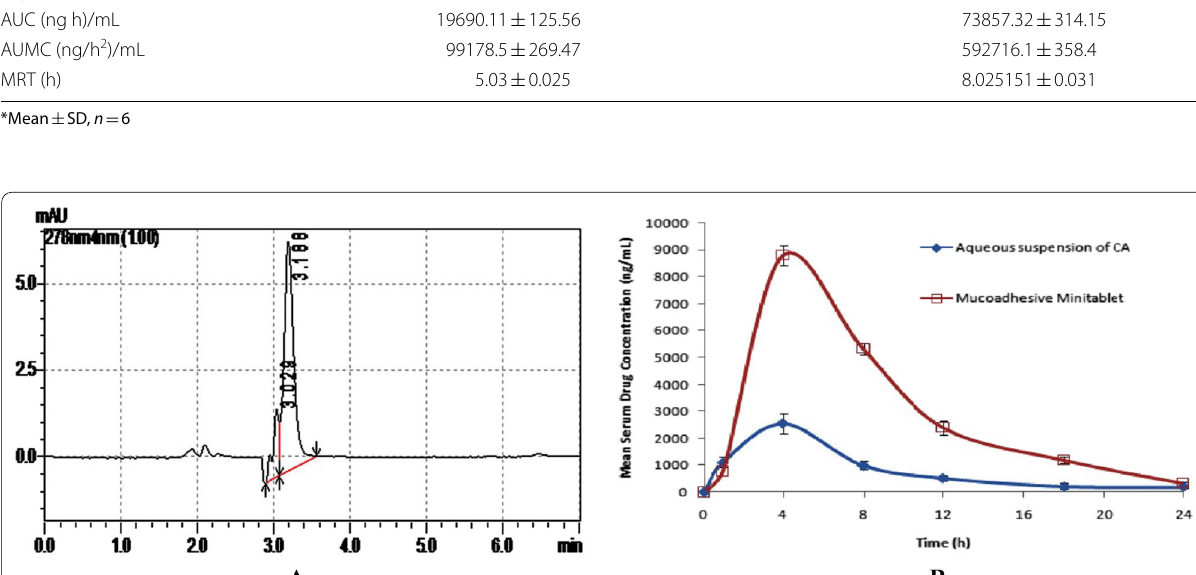
Table 7 Pharmacokinetic parameters estimation for the aqueous suspension of CA and mucoadhesive minitablets